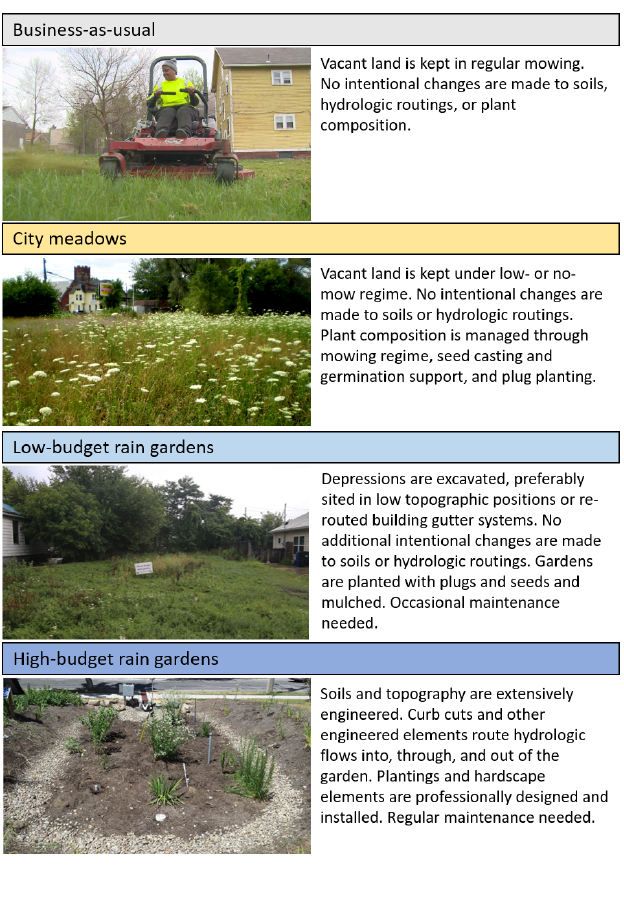
Fig. 2 . Four scenarios—Business-as-usual, City meadows, Low- budget rain gardens, and High-budget rain gardens—were schemed for a vacant land management program intended to identify desirable green infrastructure strategies in